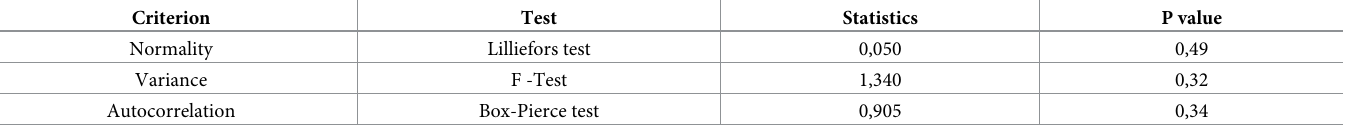
Table 1. Validation tests of the residuals from the ARIMA model (0,1,1) of the series without Box Cox transformation.